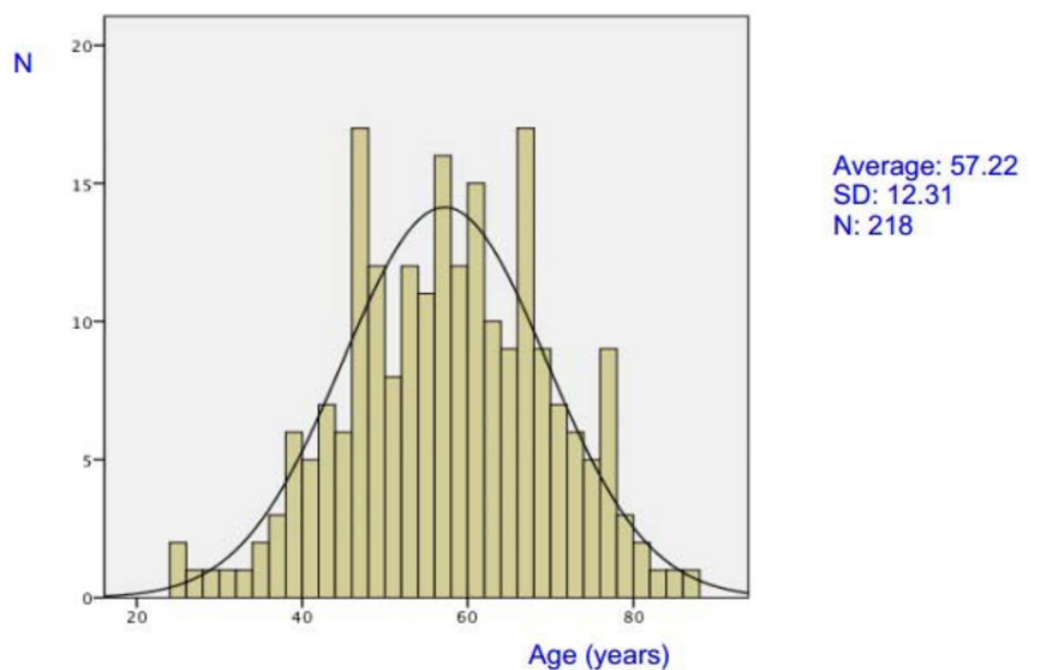
Fig 1. Age distribution in patients with amyotrophic lateral sclerosis.